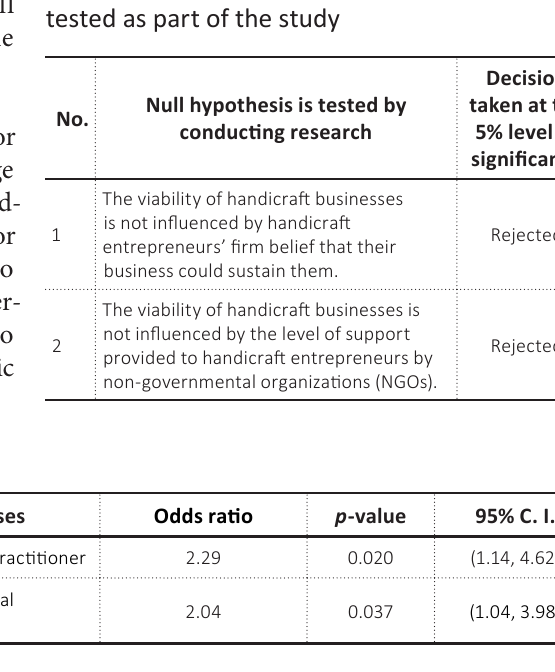
Table 7. Summary of two research hypotheses